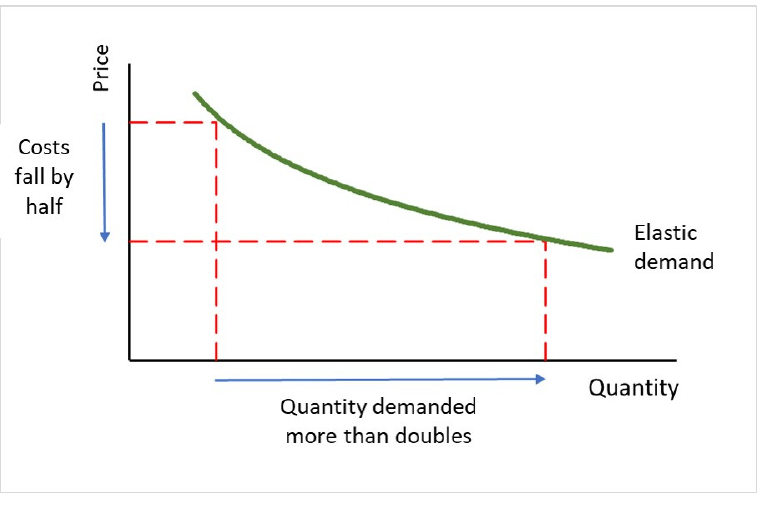
Figure 4. The effect of the elasticity of the demand on the rebound effect.